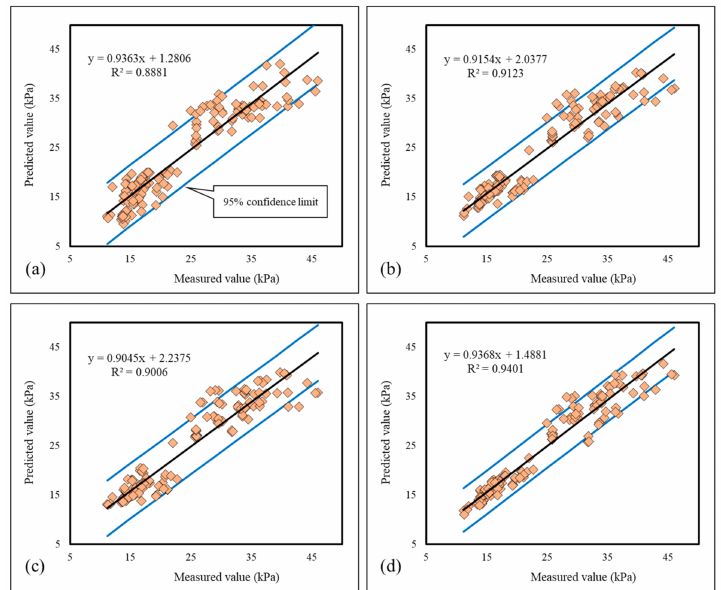
Figure 6. The consistency of the measured CLs with those predicted by ( a ) MLPNN, ( b ) GOA–ANN, ( c ) FA–ANN, and ( d ) SFS–ANN models in the testing